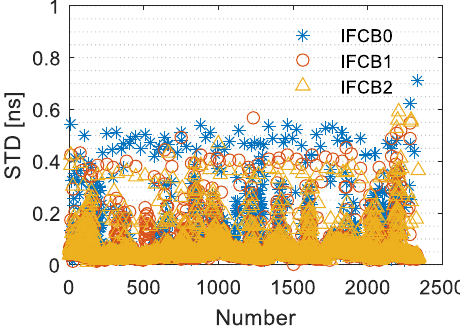
Figure 11. The STD of one-day arc solutions without fixed coordinates at three handle schemes.